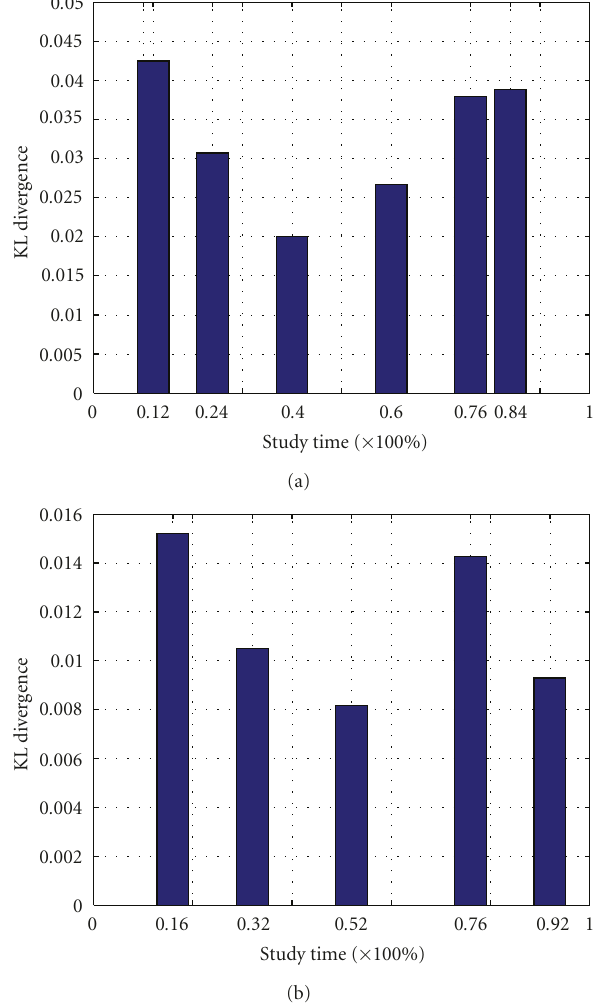
Figure 10: Reinforcement learning using WINTER algorithm in walking scenario: (a) initial prediction window size is set to 0.08 and the future testing window size is set to 0.12; (b) initial prediction window size is set to 0.12 and the future testing window size is set to